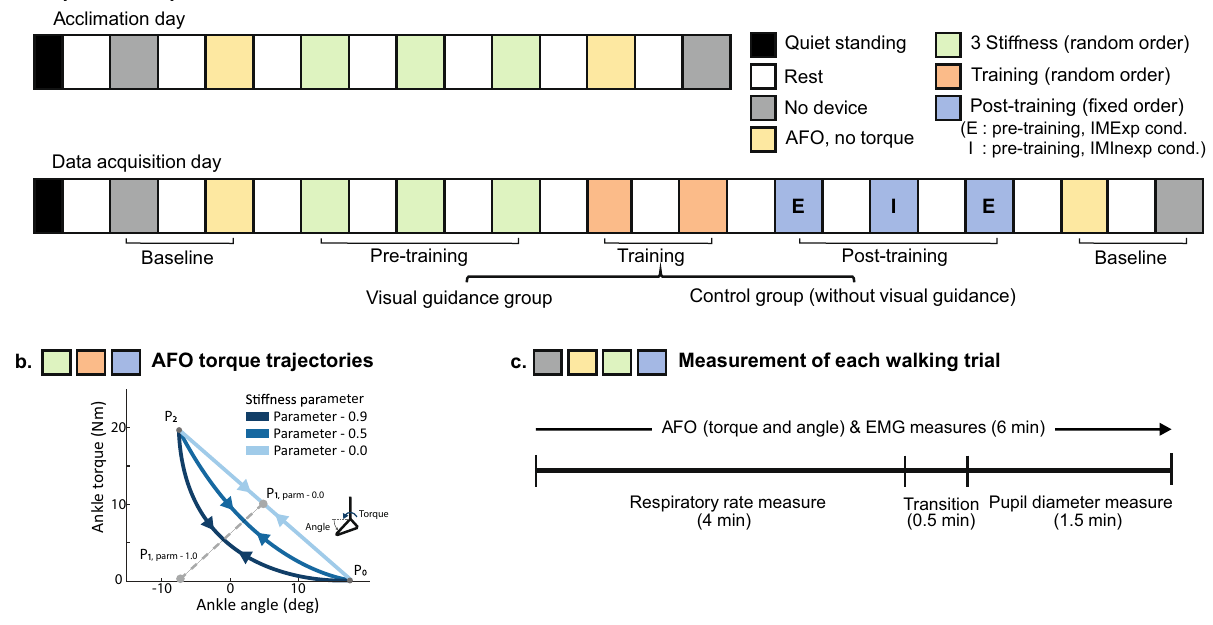
the cost by 0.15 W·Kg −1 on average for the IMInexp condition. Between the two groups, the metabolic cost of walking of the averaged two unpowered conditions and the averaged two normal walking conditions were not different (independent t -test, p > 0.16).